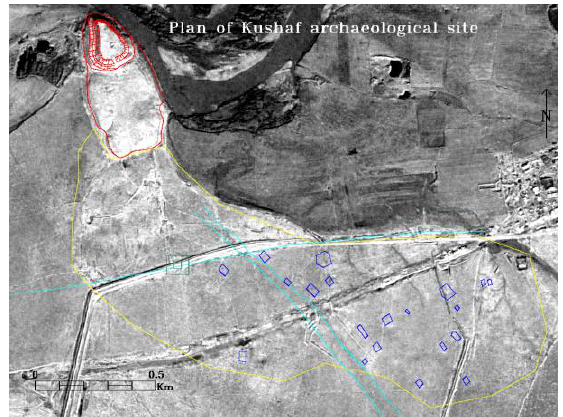
Figure 6 - Plan of Kushaf archaeological site based on FORMOSAT-2 band 1